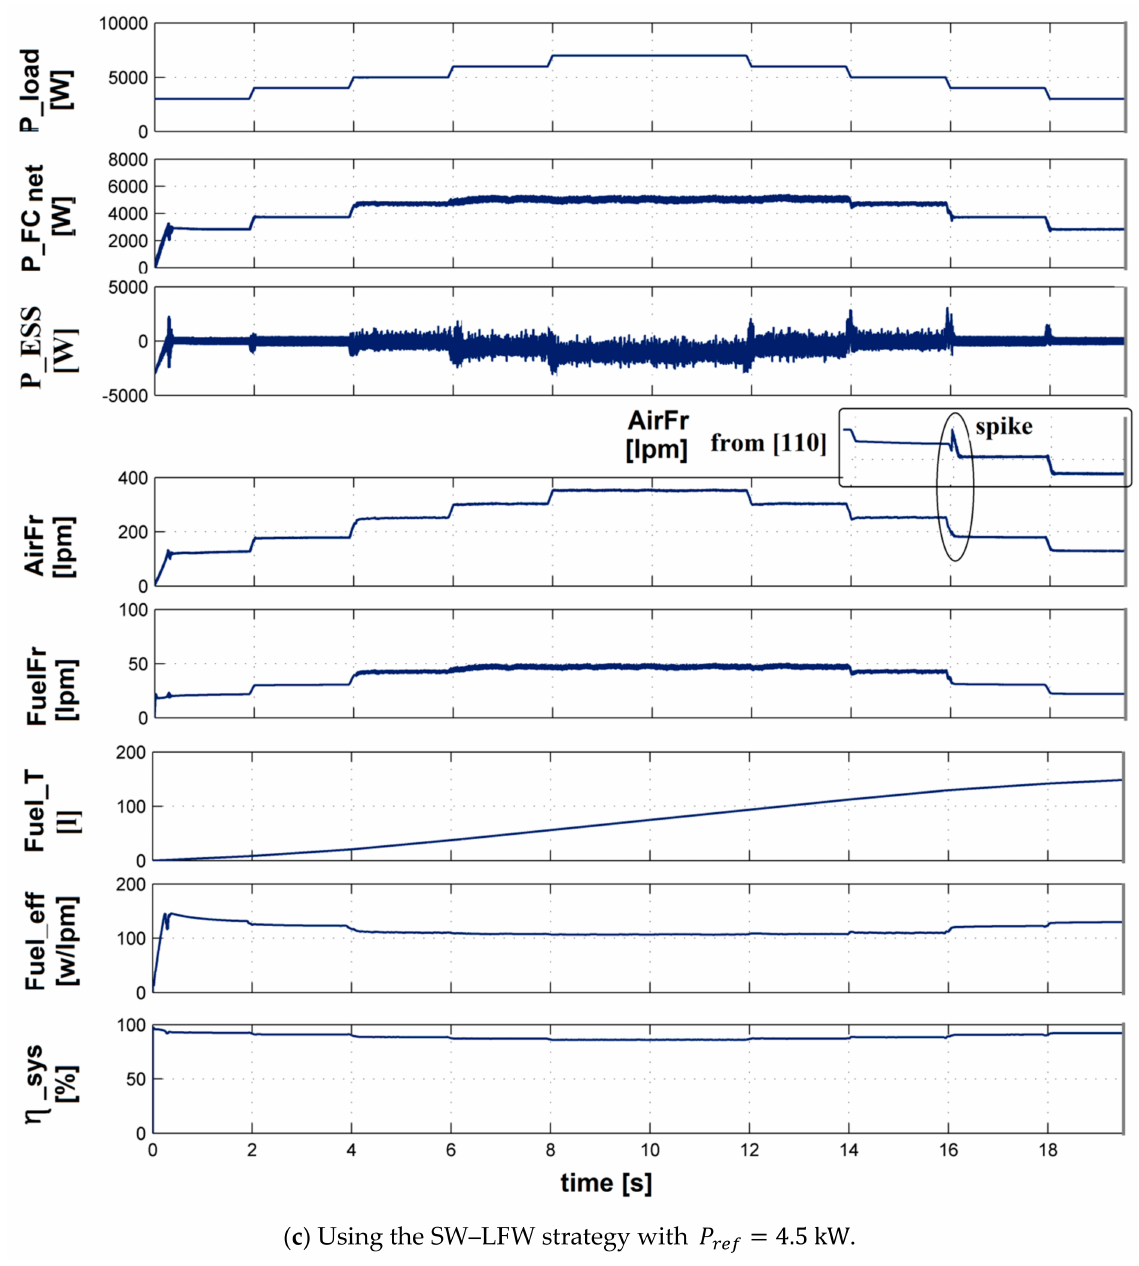
Figure 8. Behavior of the FCHPS under the third load profile (symmetrical stair up and